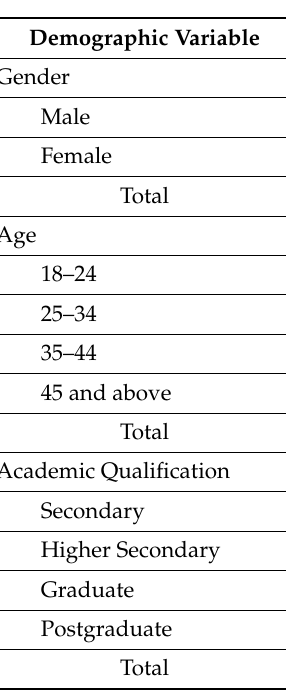
Table 1. Demographic